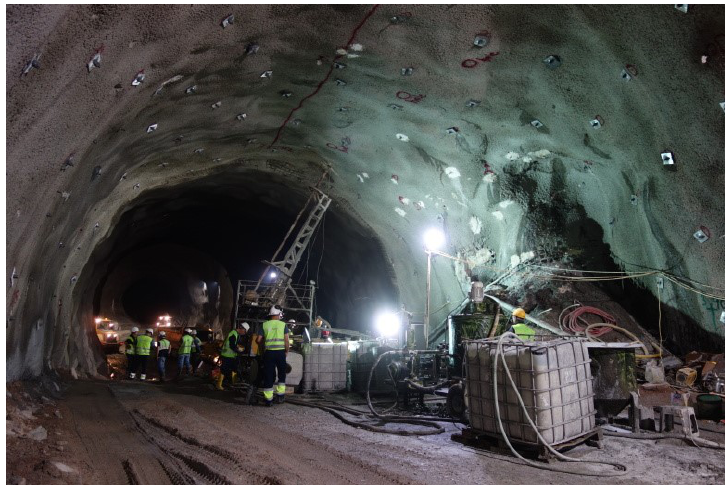
Figure 5. Grouting of the collapse 3, its mouth situated behind a barrel with grout.